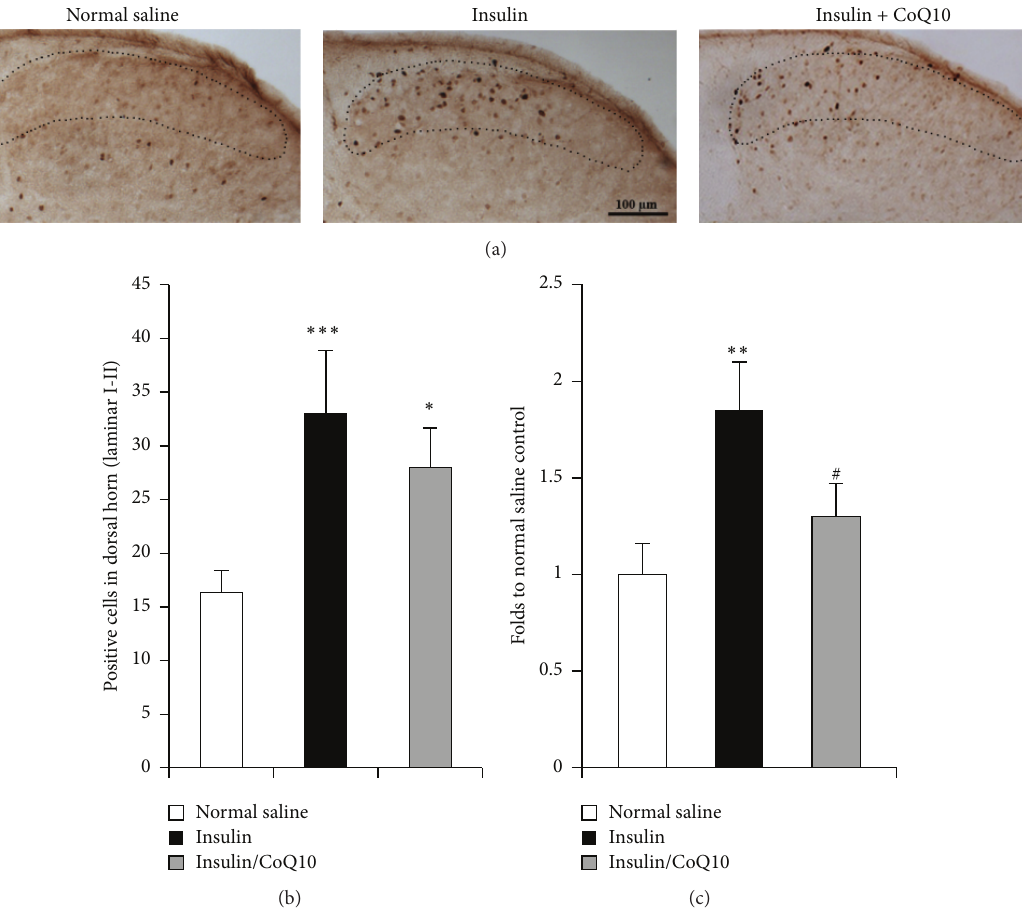
Figure 4: Immunohistology of c-Fos on lumber spinal cord and RT-PCR of c-Fos mRNA. (a) shows the expression of c-Fos in the dorsal horn of spinal cord of normal saline-injected mice, insulin-induced hypoglycemic mice, and insulin-induced hypoglycemic mice pretreated with CoQ10. (b) shows the results of image quantification in laminar I-II of the dorsal horn (dotted line area). (c) shows the result of quantification of RT-PCR of c-Fos mRNA. ∗∗∗ 𝑝 < 0.001 , ∗∗ 𝑝 < 0.01 , and ∗ 𝑝 < 0.05 compared to normal saline controls; # 𝑝 < 0.05 , CoQ10 treated group compared to insulin group (Student’s 𝑡